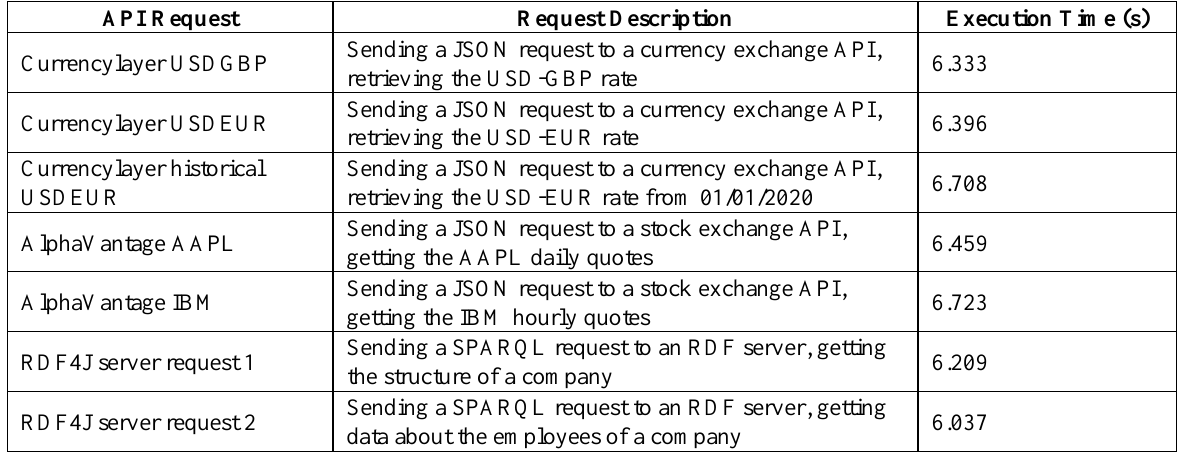
Table 1. The execution times of different web API requests